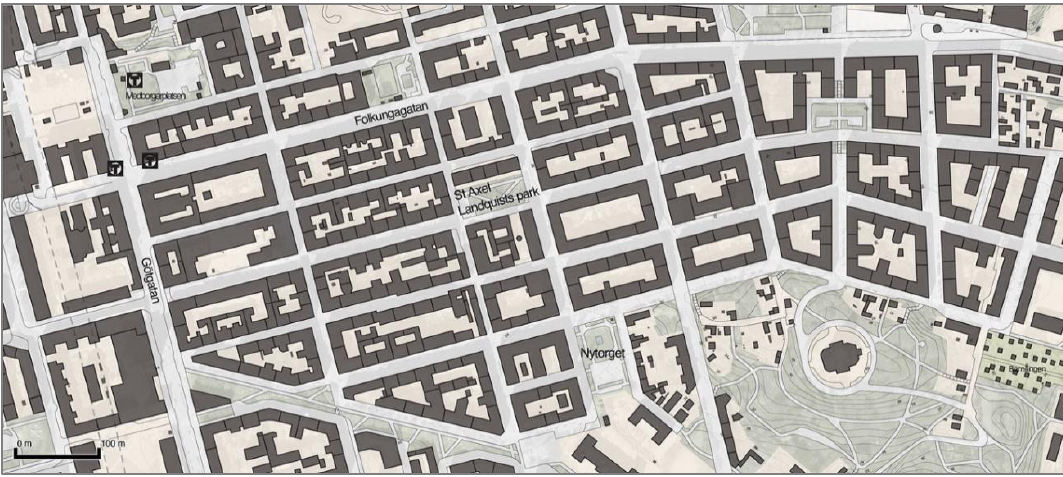
Figure 6 St. Axel Landquist’s Park and its surrounding context. The distance to Folkungagatan is 155.8 m / 122 m (130 m to intersectio n) / 2 turns (including entering the park); distance to Götgatan is 413.5 m / 406 m (408 to intersection) / 2-3 turns (including entering the park); distance to Nytorget 251.2 m / 212 m / 2 turns; distance to the subway is 503 m / 414.04 m / 3 turns (including entering the subway); distance to Medborgarplatsen is 671 m / 505 m / 4